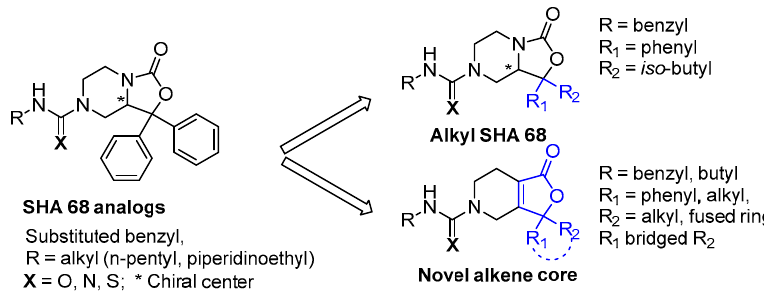
Figure 2. Further modifications to SHA led to the identification of novel alkene scaffolds.